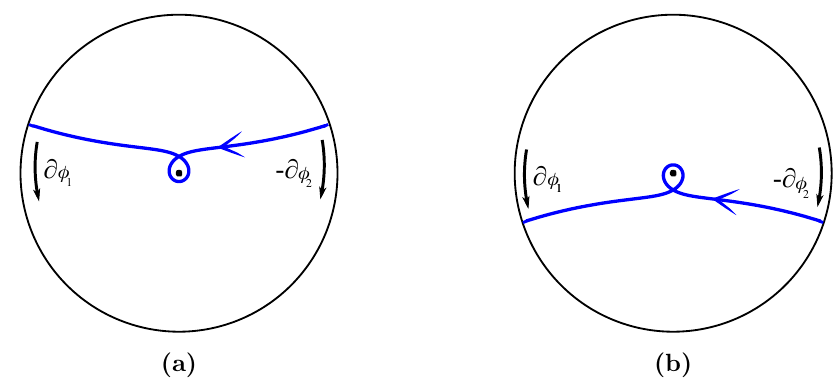
Figure 9 . Geodesics in AdS 3 with (cid:11) = (cid:25)= 2 pass through the origin, and descend to geodesics which touch the conical defect. On AdS 3 , the behaviour of such geodesics is completely smooth as (cid:11) is varied, but on the defect spacetime the endpoints may jump as (a) (cid:11) = (cid:25)= 2 (cid:0) (cid:15) increases to (b) (cid:11) = (cid:25)= 2 + (cid:15) with ~ (cid:18) held constant. This will be the case when N is not an odd integer. Despite this, the length and shape of such geodesics varies